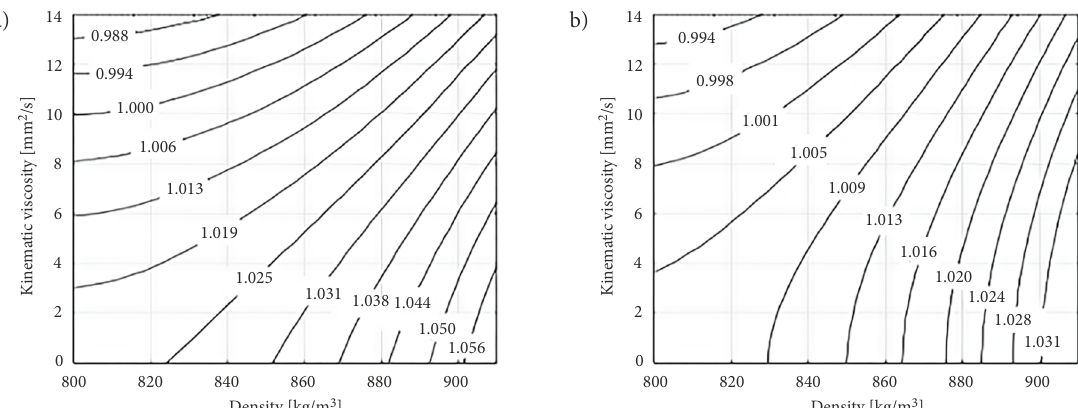
Figure 12. Multivariate characteristics of relative BSFC change in Caterpillar 3512B engine: